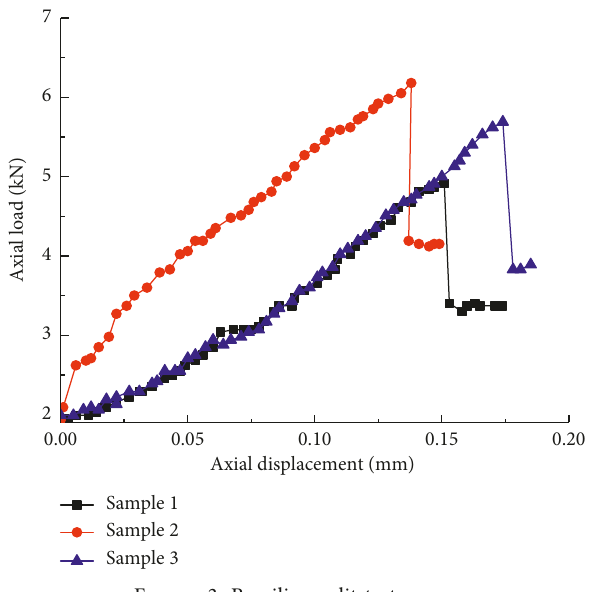
Figure 3: Brazilian split test curve.